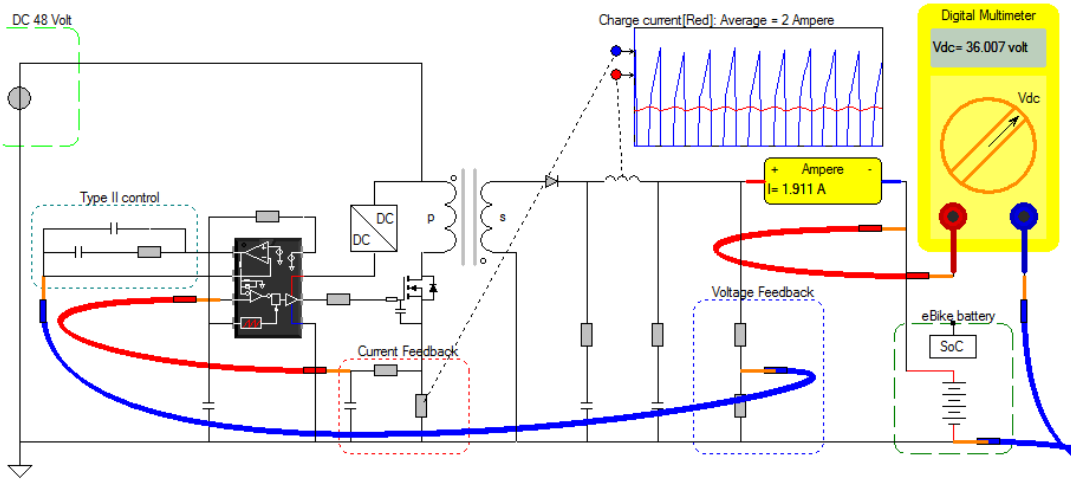
Figure 8. Current mode control of the flyback converter using an outer voltage loop and an inner current current loop.